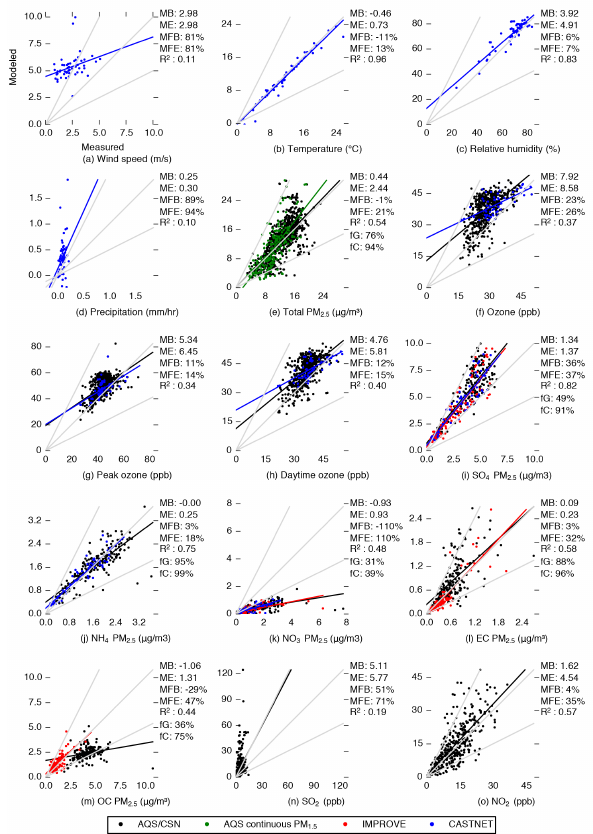
Figure 3. Annual average modeled and measured ground-level (a – d) meteorological variables and (e – o) pollutant concentrations. Col- ored lines show linear least-squares fits of the data for the measure- ment networks with corresponding colors. Grey lines show model to measurement ratios of 2 : 1, 1 : 1, and 1 : 2. Annual average per- formance statistics are listed to the right of each plot; acronyms are defined in the methods section.